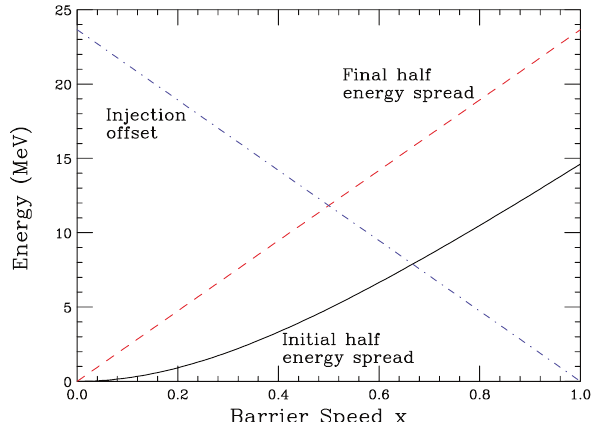
FIG. 4. (Color) Given a barrier speed, the plot shows the critical initial half energy spread of the booster batch D E 1 (cid:1) 2 i , the initial energy offset D E i 1 , and the final half energy offset D E f 1 .